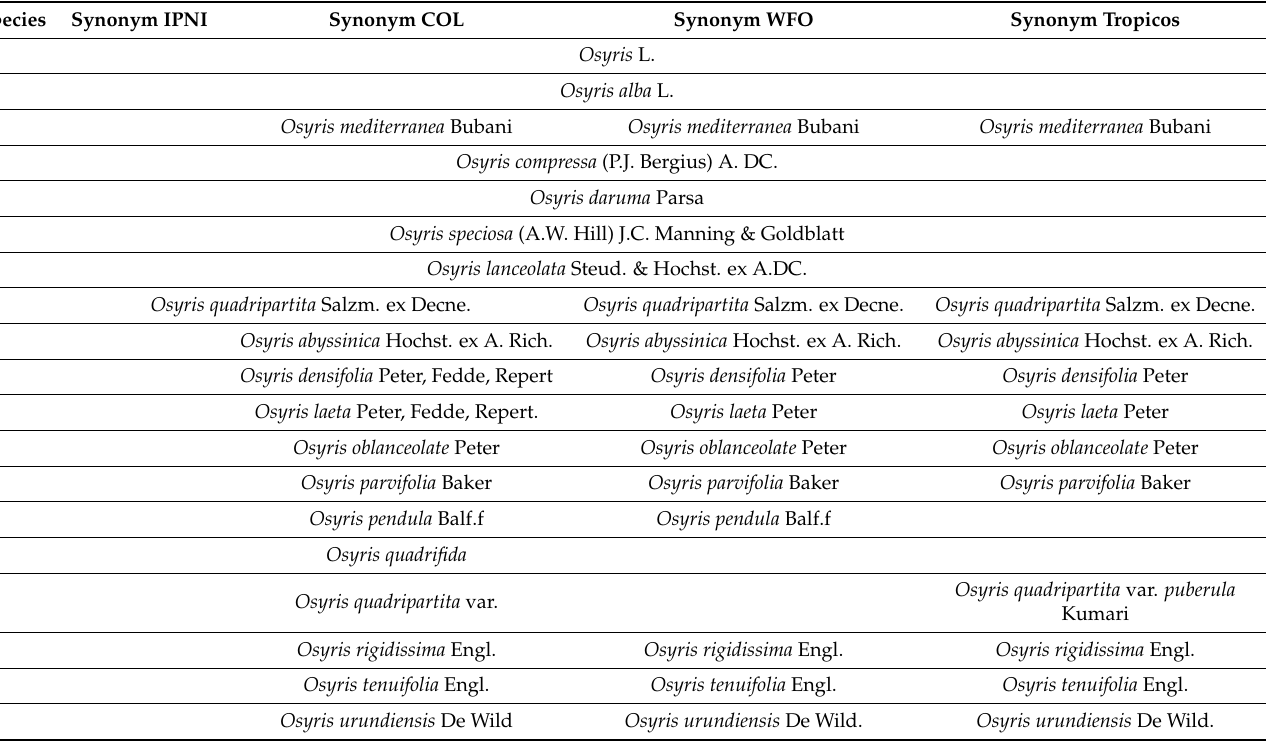
Table A1. Summary of accepted species(genus Osyris) and synonyms in the treatments of IPNI, COL, WFO and Tropicos. COL does not accept O. lanceolata but divides it into O. quadripartita and O. wightiana. Species Synonym IPNI Synonym